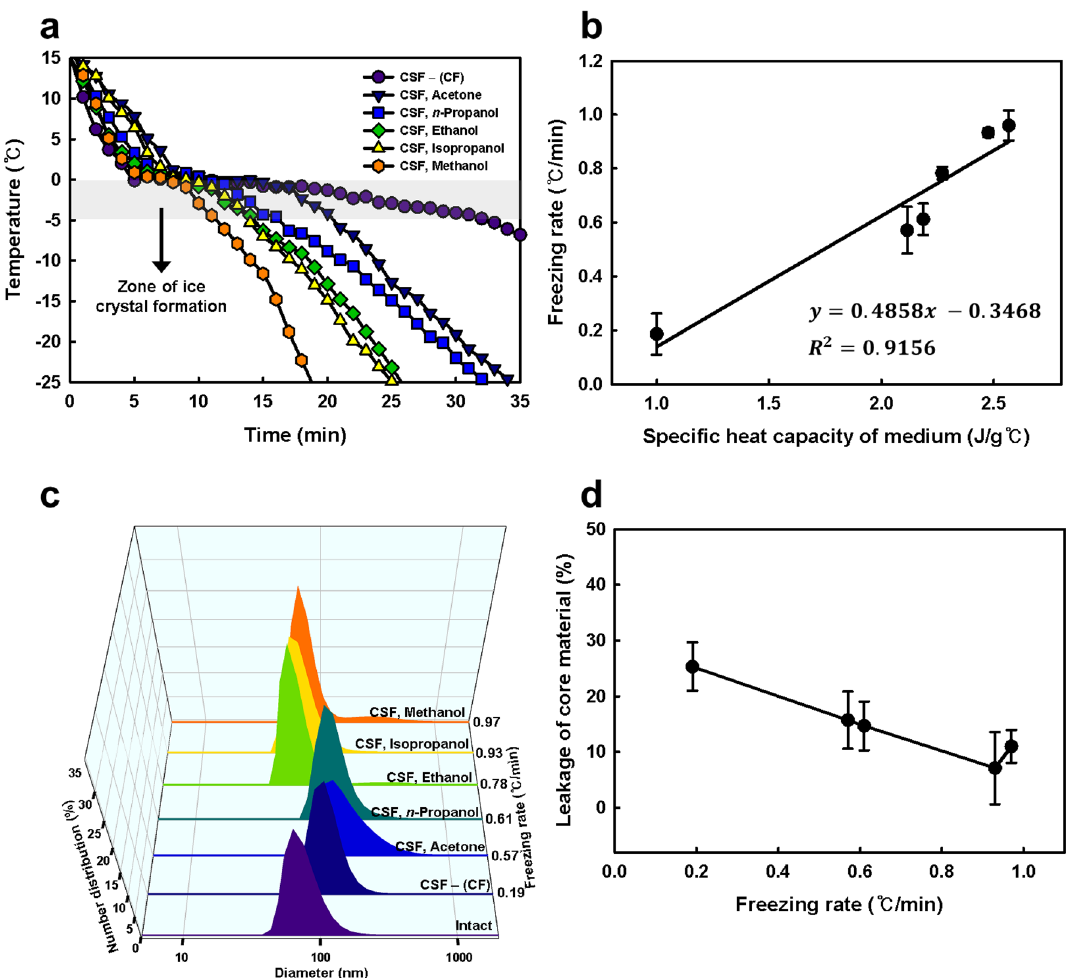
Figure 2. Effects of the medium (organic solvent) in the CSF system on the freezing rate and physicochemical properties of lipid nanovesicles. ( a ) Temperature profiles of lipid nanovesicles in the conventional freezing and CSF systems with different media. ( b ) Correlation between the specific heat capacity of the medium and freezing rate of lipid nanovesicles. ( c ) Size distribution and ( d ) leakage of encapsulated material (fluorescent calcein) of lyophilized lipid nanovesicles in the various freezing systems with different freezing rates. The size distribution and leakage of lyophilized lipid nanovesicles were measured after heat of fusion produced by the phase change of water from a liquid to crystalline form. These results suggest that as the specific heat capacity of the liquid medium increases, a higher driving force for heat transfer is provided to the sample solution, which increases the freezing rate accordingly. Furthermore, it is possible to precisely control the freezing rate by simply changing the liquid medium in the CSF system (Supplementary Fig. S2). The effect of the freezing rate on the integrity of the lipid bilayer membrane was evaluated by measuring the size distribution of lipid nanovesicle after lyophilization (Fig. 2c). The intact lipid nanovesicle prior to lyophiliza- tion had a Z-average diameter (D z ) of 120.7 nm and polydispersity index (PDI) of 0.159, and transmission elec- tron microscopy (TEM) images showed a monodispersed morphology of the lipid nanovesicles (Supplementary Fig. S3). Compared with the size distribution of intact lipid nanovesicles, changes in D z and PDI were observed in all of the lyophilized lipid nanovesicles. However, the changes in the size distributions of the lyophilized lipid nanovesicles differed significantly among the different freezing systems. The D z and PDI of lyophilized lipid nanovesicles showed the greatest changes in the conventional freezing and CSF systems with acetone and the smallest changes in the CSF system with isopropanol, suggesting that the change in size distribution decreased as the freezing rate increased (Supplementary Fig. S4). Nevertheless, lyophilized lipid nanovesicles in the CSF system with methanol, in which the freezing rate was highest, showed a greater increase in D z compared with the CSF system with isopropanol. These results suggest that too quick freezing leads to disruption of the lipid bilayer membrane, and the membrane integrity of lipid nanovesicles can be maintained completely after lyophilization when the appropri- ate freezing rate is applied. It is well documented that too quick freezing, such as immersion of small volume suspension in liquid nitrogen, reduces disruption of the lipid bilayer membrane, since the freezing results in the formation of fine ice crystal and homogenous dispersion of LPA. However, several studies have shown that the